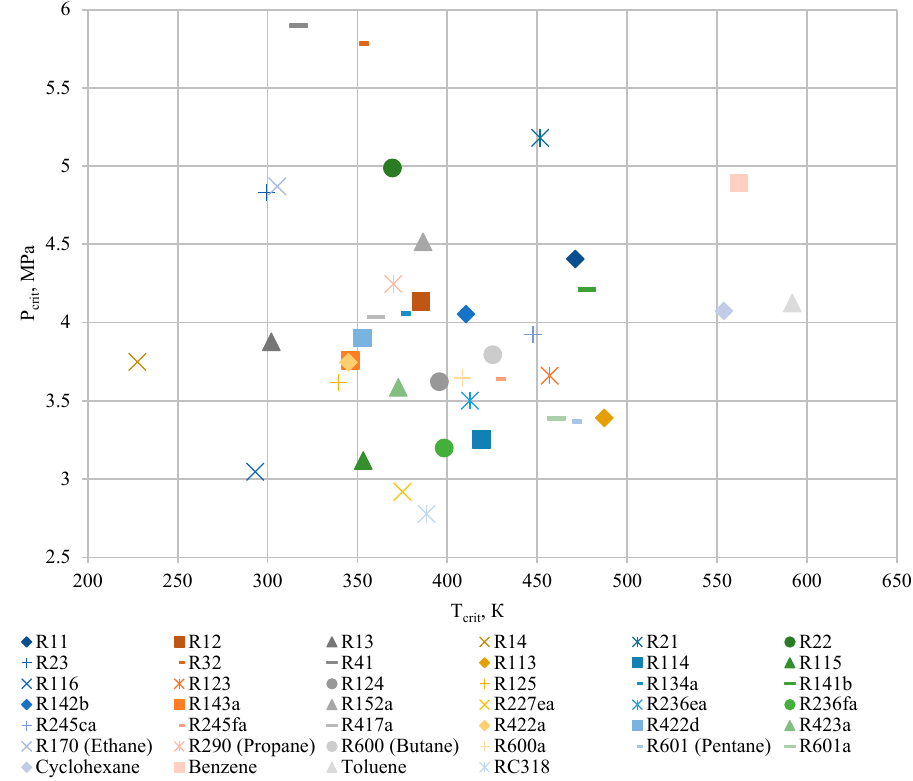
Figure 1. Critical parameters of working fluids.